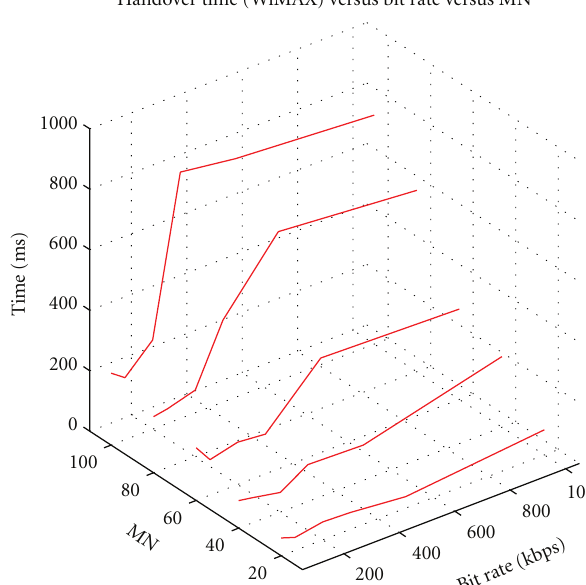
Figure 14: HO time (WiMAX) versus bit rate versus no. of MNs.